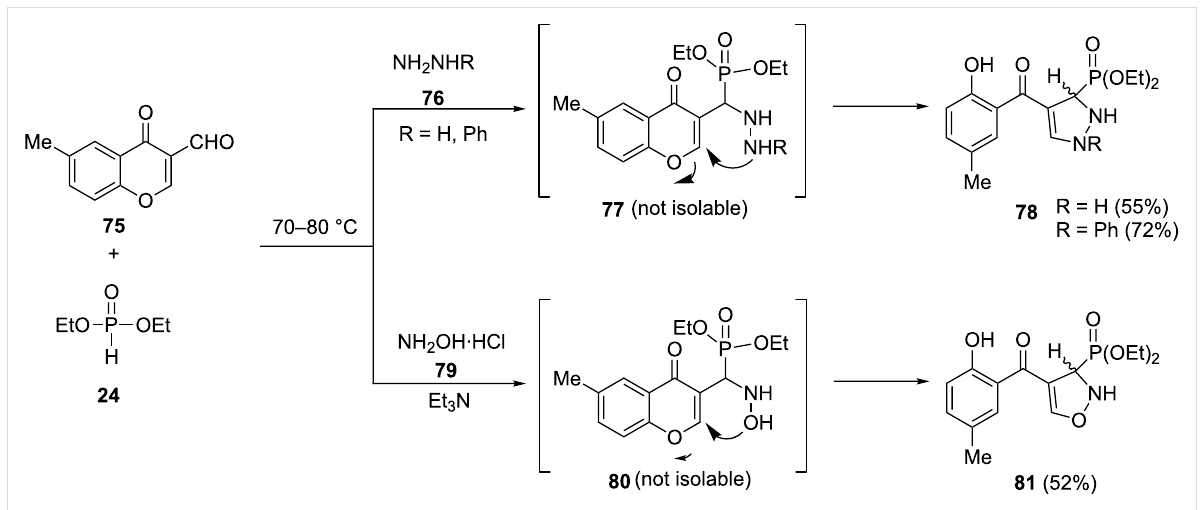
Scheme 19: Three-component reaction of 6-methyl-3-formylchromone ( 75 ) with hydrazine derivatives or hydroxylamine in the presence of diethyl